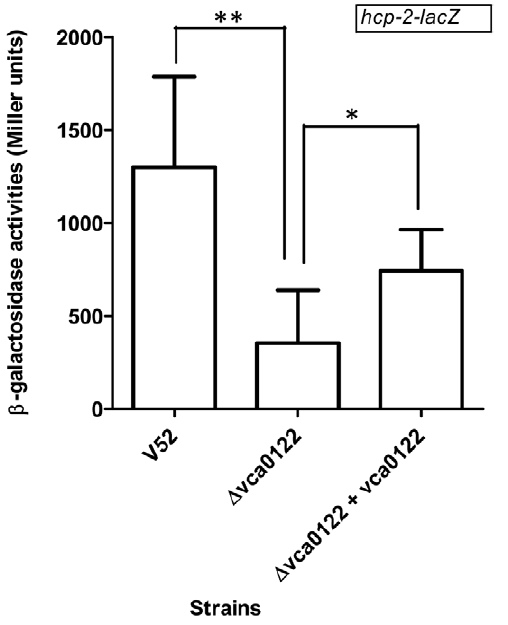
Figure 2. VCA0122 is a positive regulator of T6SS. The regulation of VCA0122 on T6SS substrate gene hcp-2 was examined using lacZ reporter plasmid. Bacteria were cultured in LB broth. The values represent the mean 6 SD. Data were analyzed with student’s t test. ** indicates p , 0.001 and * indicates p , 0.05.